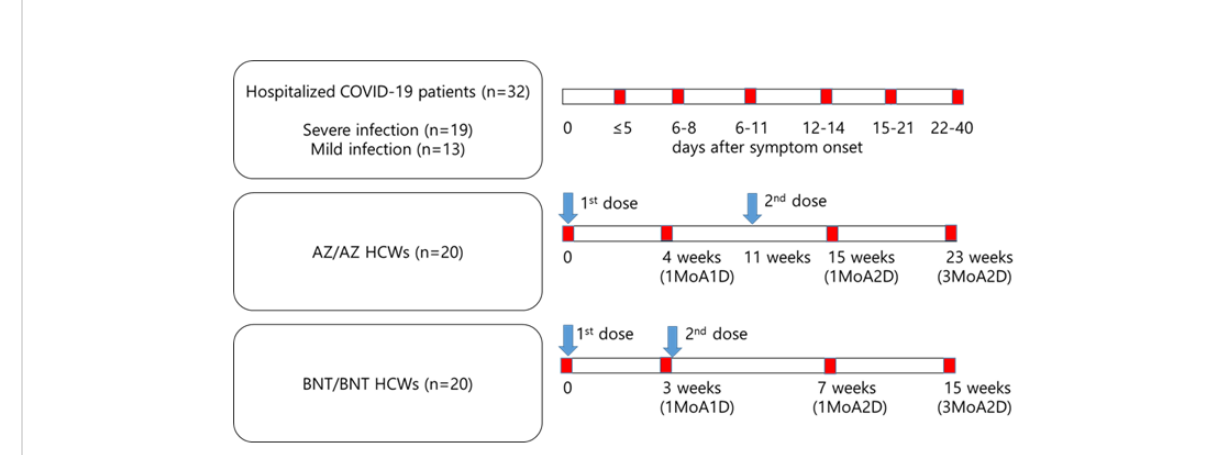
FIGURE 1 Red boxes indicate when serum samples were collected and antibodies were